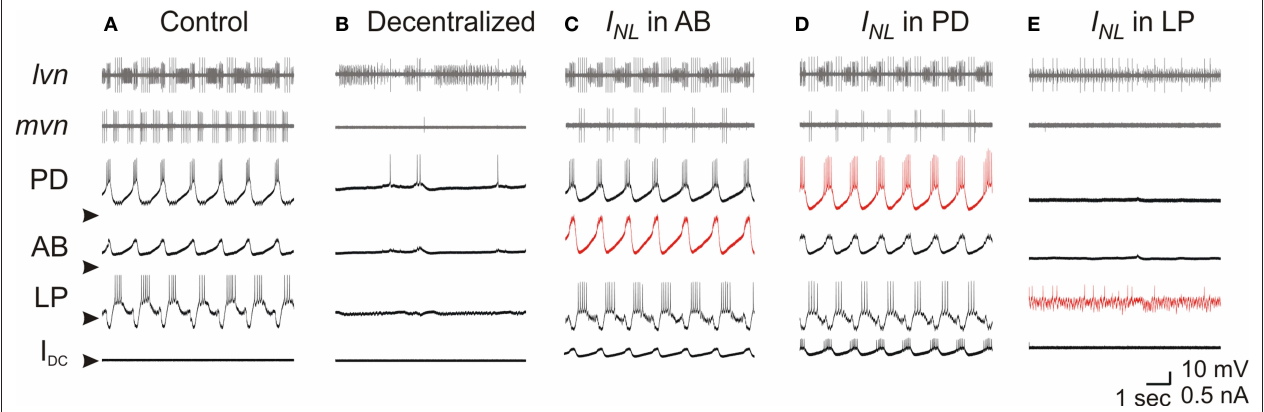
( C,D) Rhythmic activity that strongly resembles the control pyloric activity is observed when negative leak current I neuron (C) as well as into one of the two PD neurons (D) . (e) No rhythmic activity can be induced when negative leak current I follower LP neuron. Arrowheads point to − 60 mV and 0